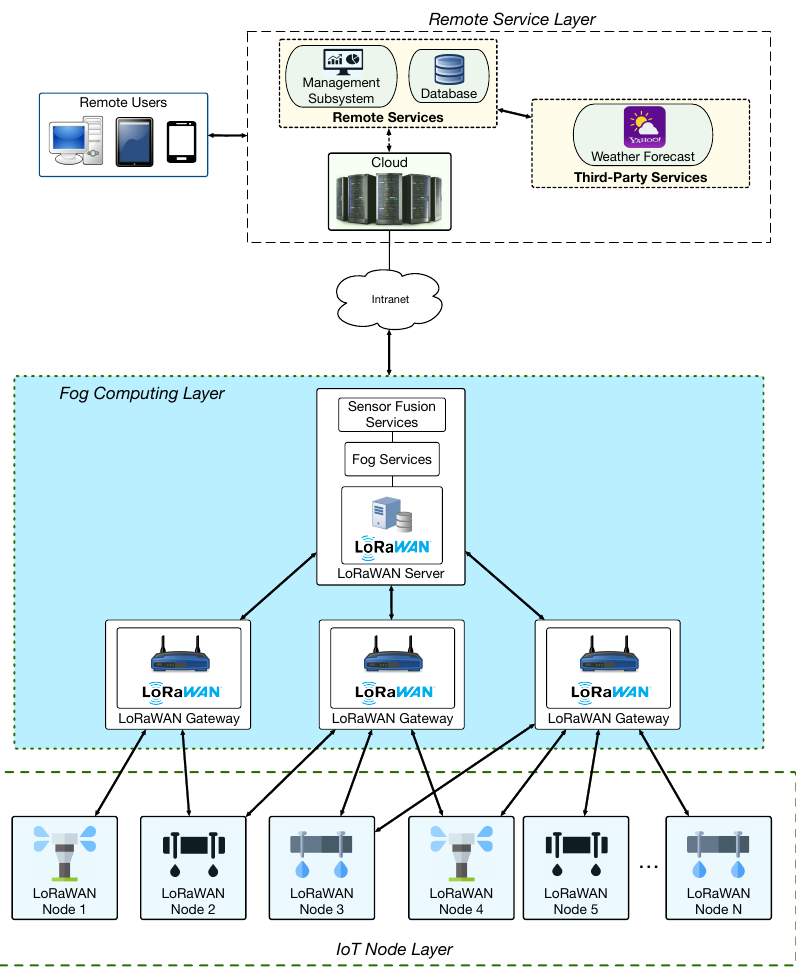
Figure 4. Implemented communications